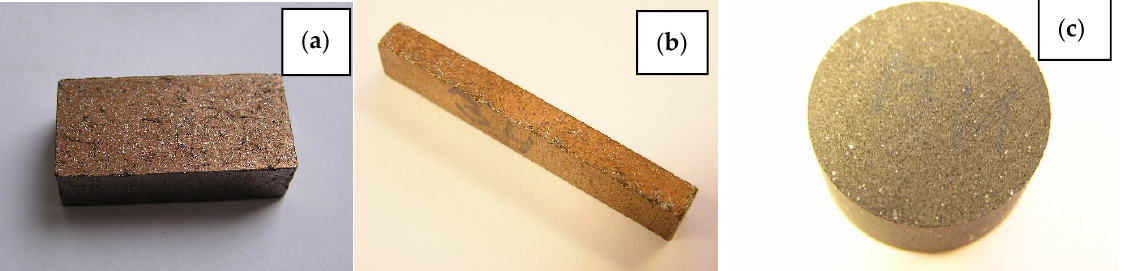
Figure 13. Elements filled with W-B (30–50%) based on copper ( a , b ) and iron ( c ) powder after pressing and sintering.